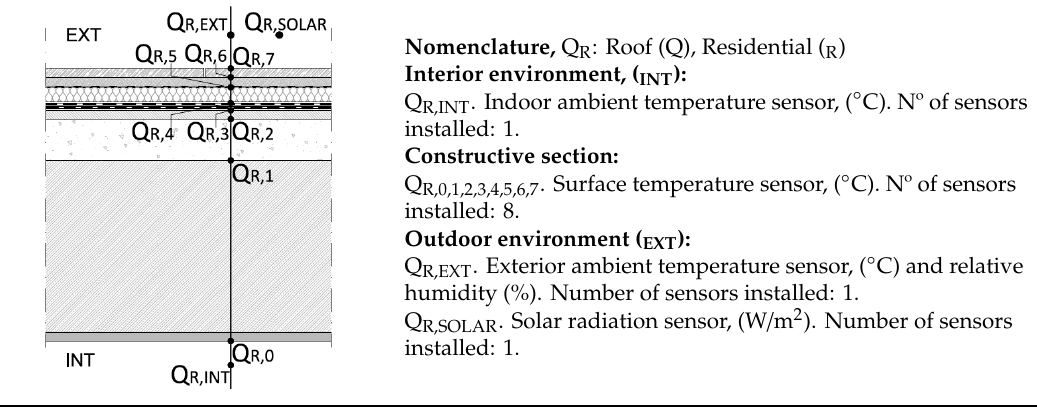
Table 3. Location and description of sensors located on the inverted flat roof of the flat. Appl. Sci. 2019 , 9 , x FOR PEER REVIEW